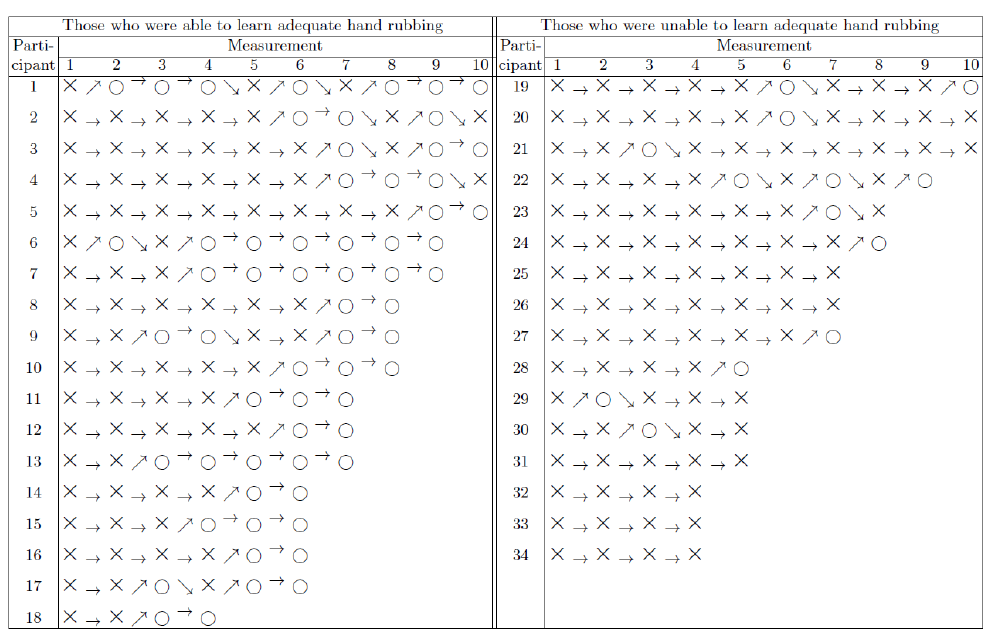
Figure 4. Measurement time series of individual HCWs performed with 1.5 mL ABHR, represented with a Markov model. Symbols ○ and × stand for adequate and inadequate coverage, respectively. Arrows highlight the changes between the outcomes of consecutive measurements.